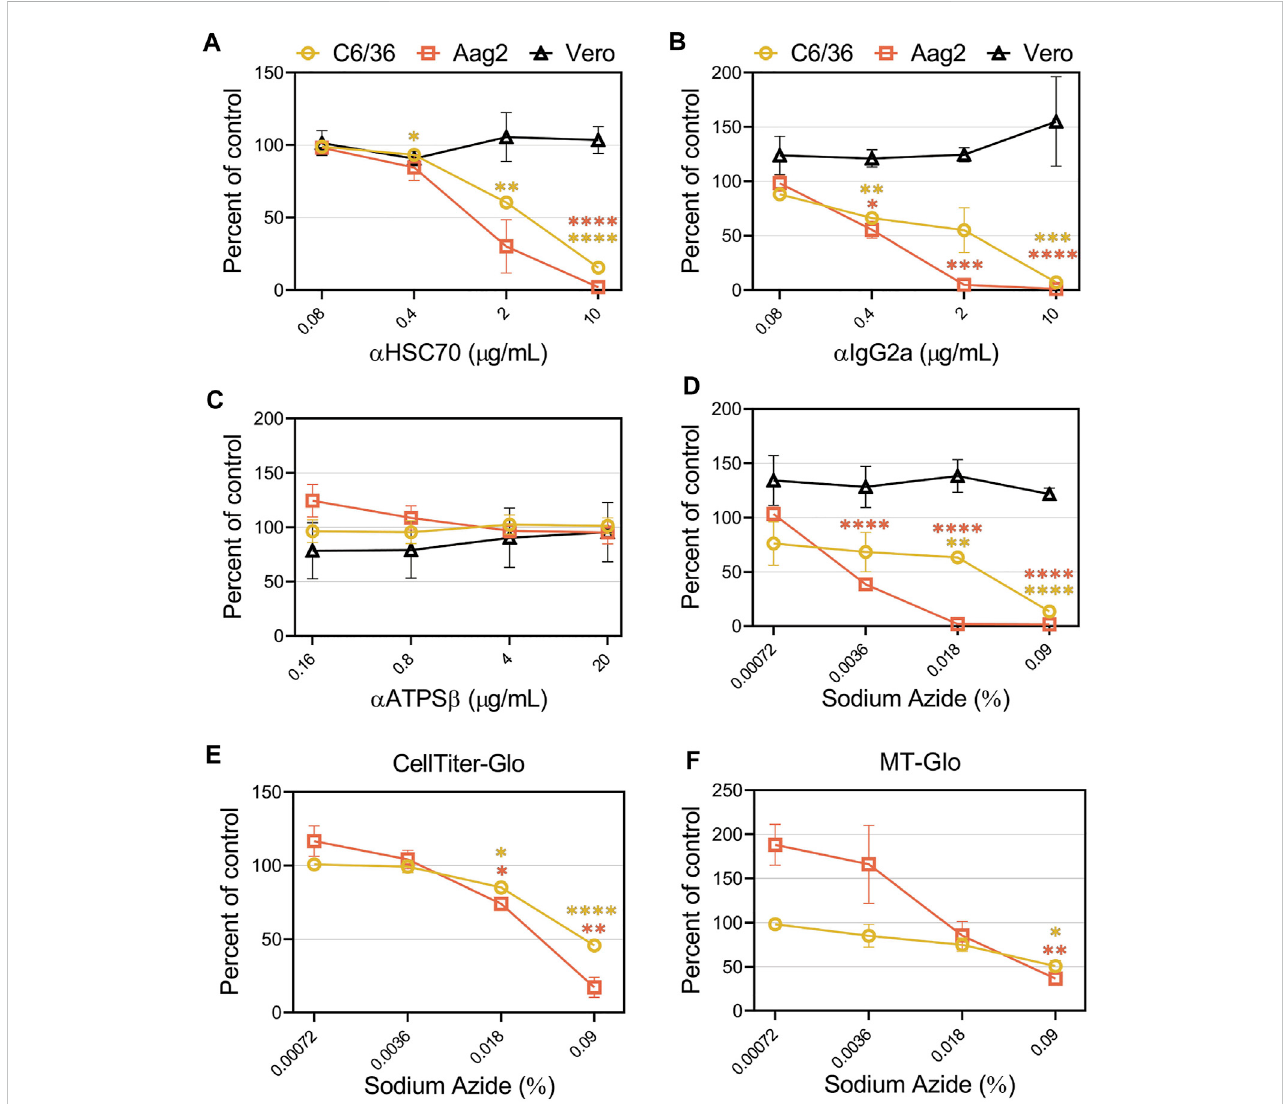
FIGURE 7 Sodium azide preservatives cause inhibition of CHIKV production in mosquito cells. CHIKV-Nluc stocks were used to assess the ability of (A) HSC70, (B) IgG2a, (C) ATPS β , or (D) sodium azide only to block infections into either C6/36, Aag2, or Vero cells at the indicated concentrations. 24 h following infection thecellswerelysedwithNanoGlosubstrateandlysateswerequanti fi edwithaGloMaxExplorer.CellviabilityofinfectedC6/36andAag2cellswasdetermined after treatment with sodium azide or PBS as control by measuring ATP levels (E) or reducing potential of the cells (F) . 24 h following infection the cells were lysed with Cell Titer Glo or RealTime-Glo MT, respectively, and quanti fi ed with a GloMax Explorer. Data are presented as the mean ± SEM from at least three independent experiments performed in duplicate. Unpaired parametric Student ’ s t-test with Welch ’ s correction was performed to determine statistical signi fi cance compared to a no-treatment control. *, p < .05; ***, p < .001; ****, p <